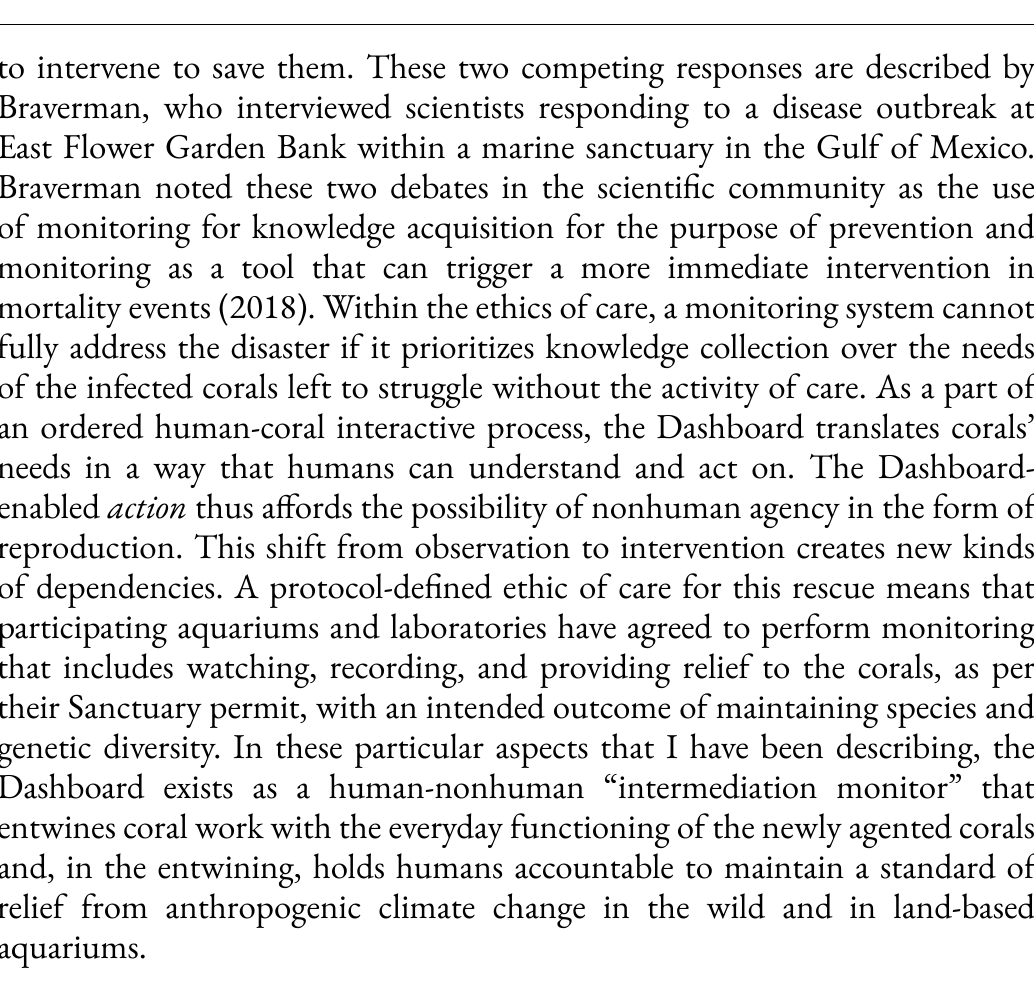
Figure 3: Coral no. 8 at rescue site 4586. Photo by FWC Fish and Wildlife Research Institute, taken on September 12, 2018. Source: FWC Fish and Wildlife Research Flickr Account. NonCommercial-NoDerivs 2.0 Generic (CC BY-NC-ND